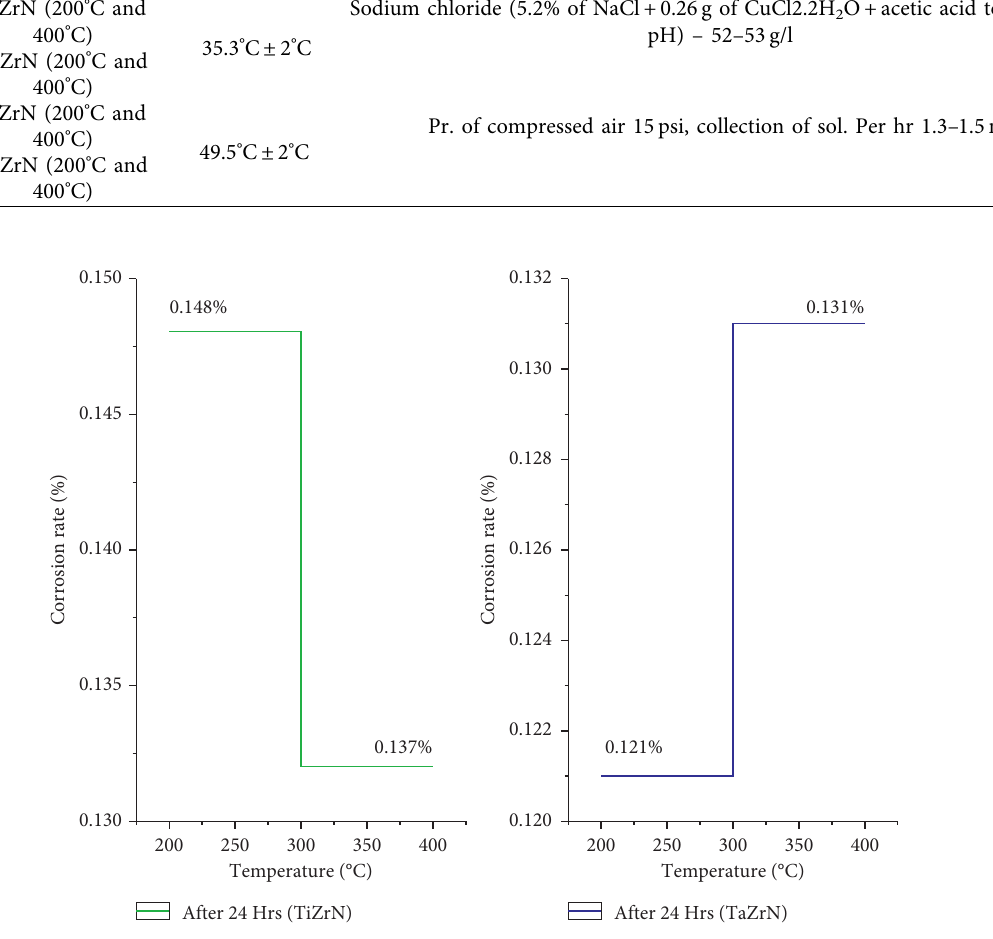
Figure 7: Temperature vs corrosion rate (%) for humidity